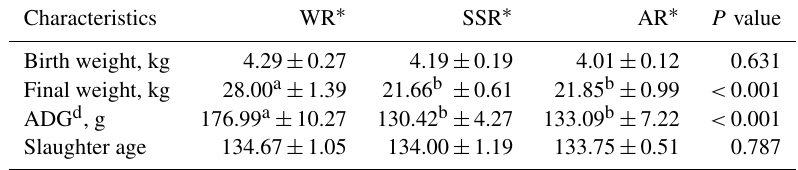
Table 1. Means ± SE (standard errors) for birth weight, final live weight and average daily gain in lambs reared in different seasons.